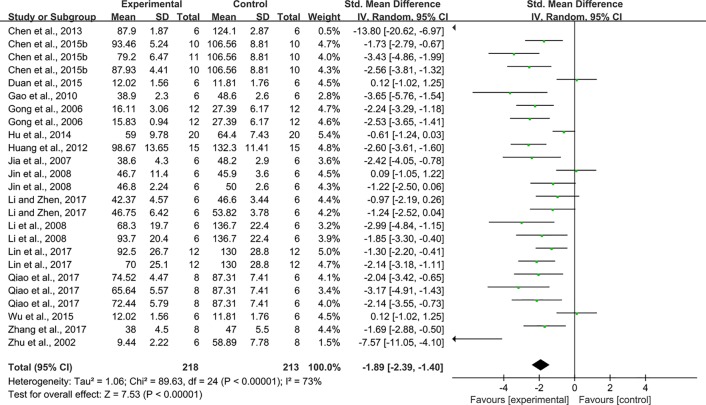
Pooled estimate of Scr with rhein.